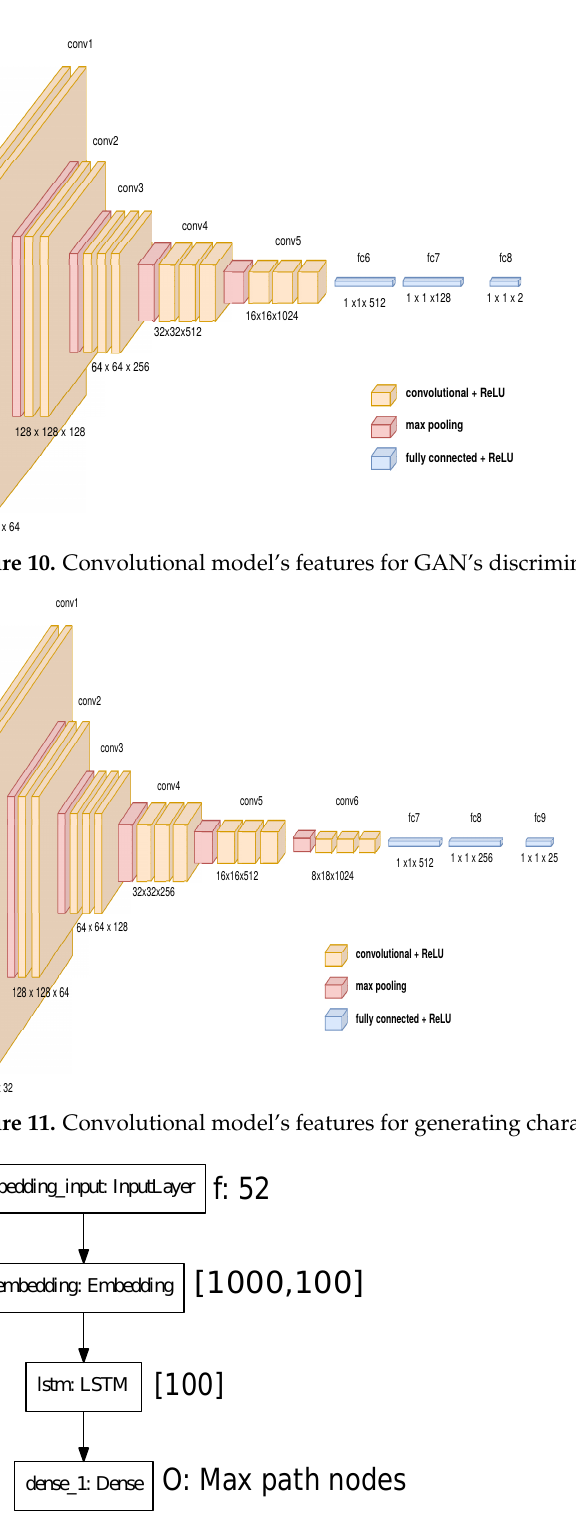
Figure 12. Recurrent neuronal network model’s features for generating